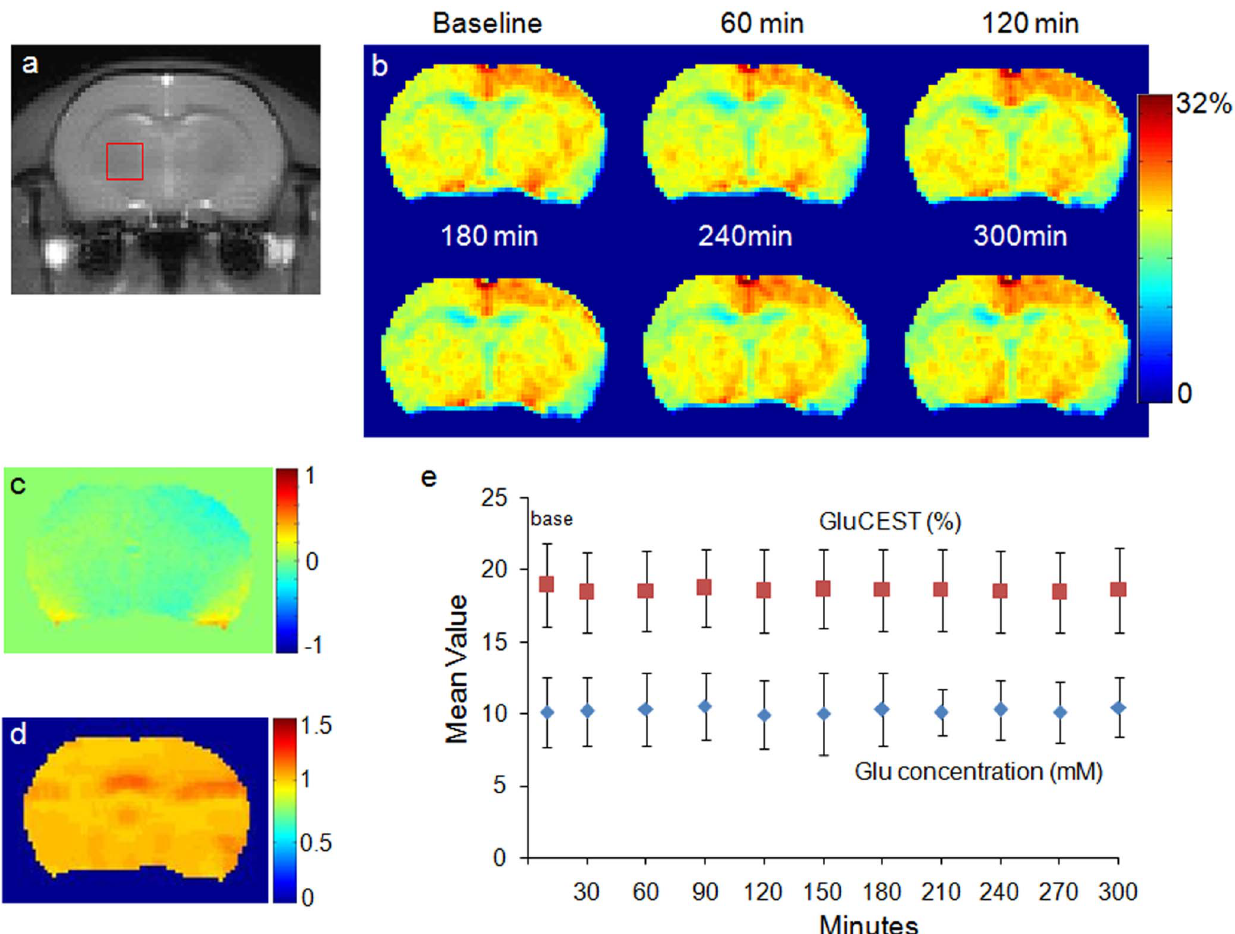
Figure 1. Chemical-exchange-saturation-transfer imaging of glutamate (GluCEST). (a) Anatomical brain image from one of the group 1 normal rat. (b) GluCEST maps of this rat brain pre and post Modafinil injection over time period of 5 hours. (c, d) B 0 and B 1 maps from corresponding brain slice as shown in (a). (e) graphs show no appreciable change in either mean GluCEST contrast or mean Glx concentration from 1 HMRS over time period of 5 hours (n=5) for the region of interest as shown in (a).